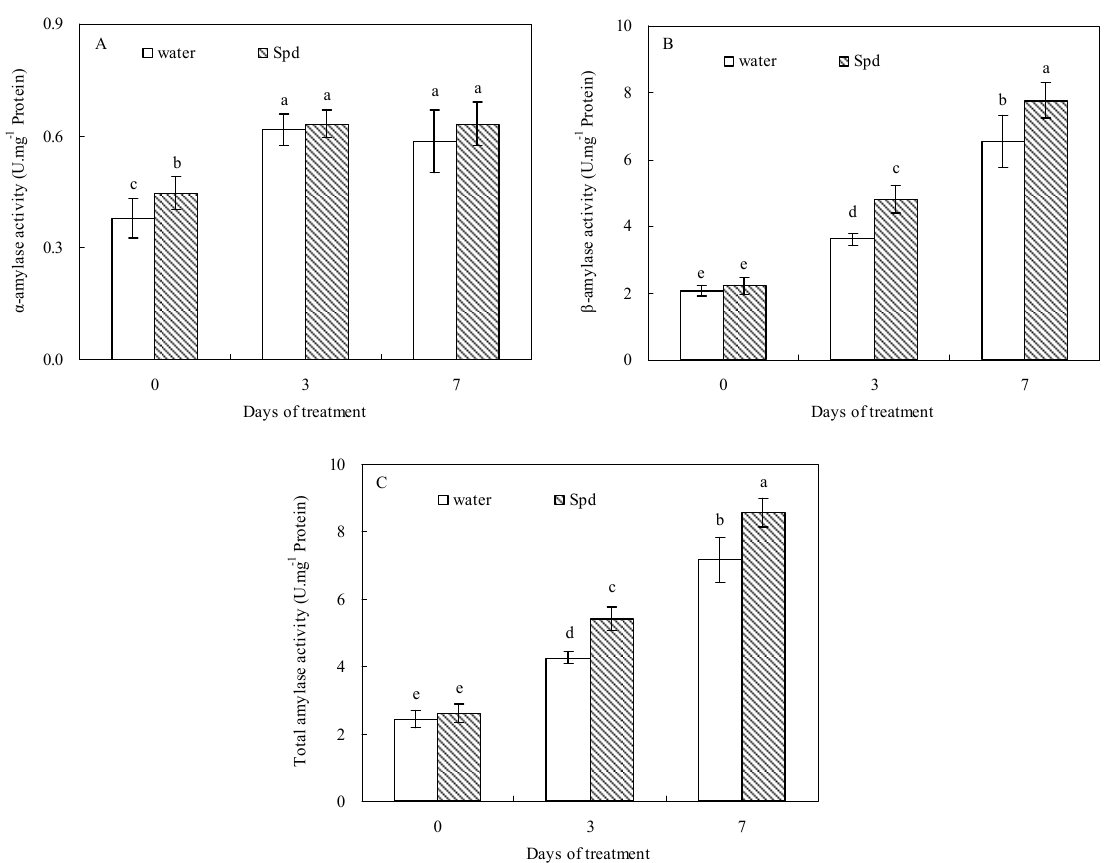
Figure 2. The effect of seed soaking with water or spermidine (Spd) on ( A ) α -amylase activity; ( B ) β -amylase activity and ( C ) total amylase activity in the process of seeds germination (7 days) under water stress induced by 15% PEG. Vertical bars indicate ± SE of mean ( n = 6). Different letters above columns indicate significant difference. LSD ( p ≤